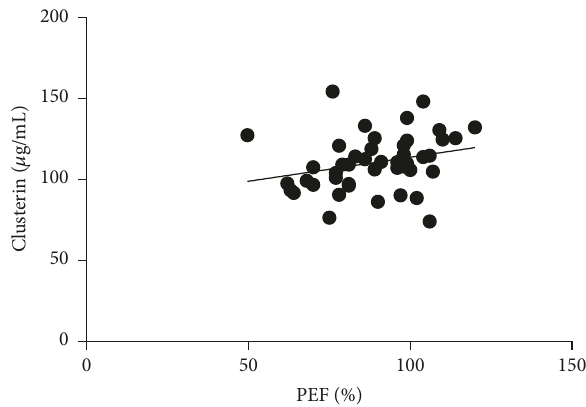
Figure 5: Positive correlation of PEF and circulating clusterin levels in asthmatic patients (pregnant and nonpregnant). 𝑝 = 0.0221 ; 𝑟 = 0.3405 .